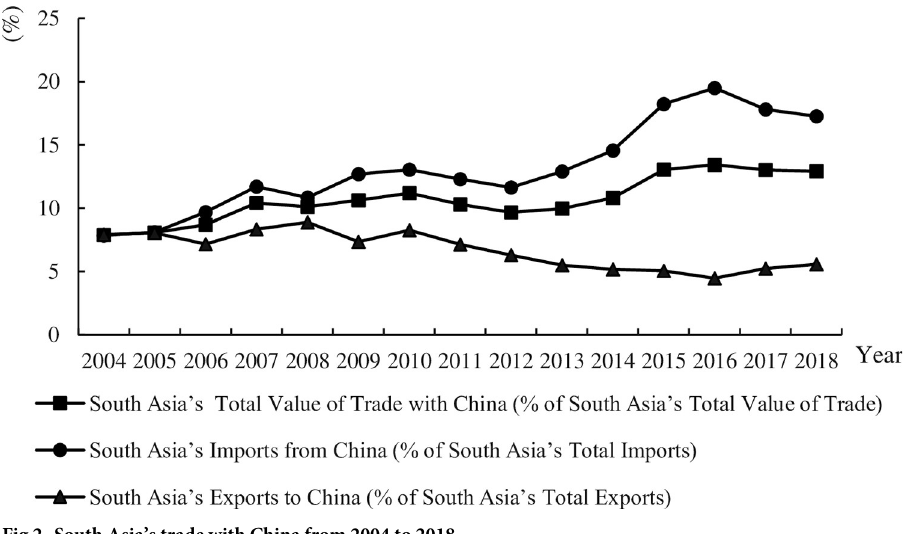
Fig 2. South Asia’s trade with China from 2004 to